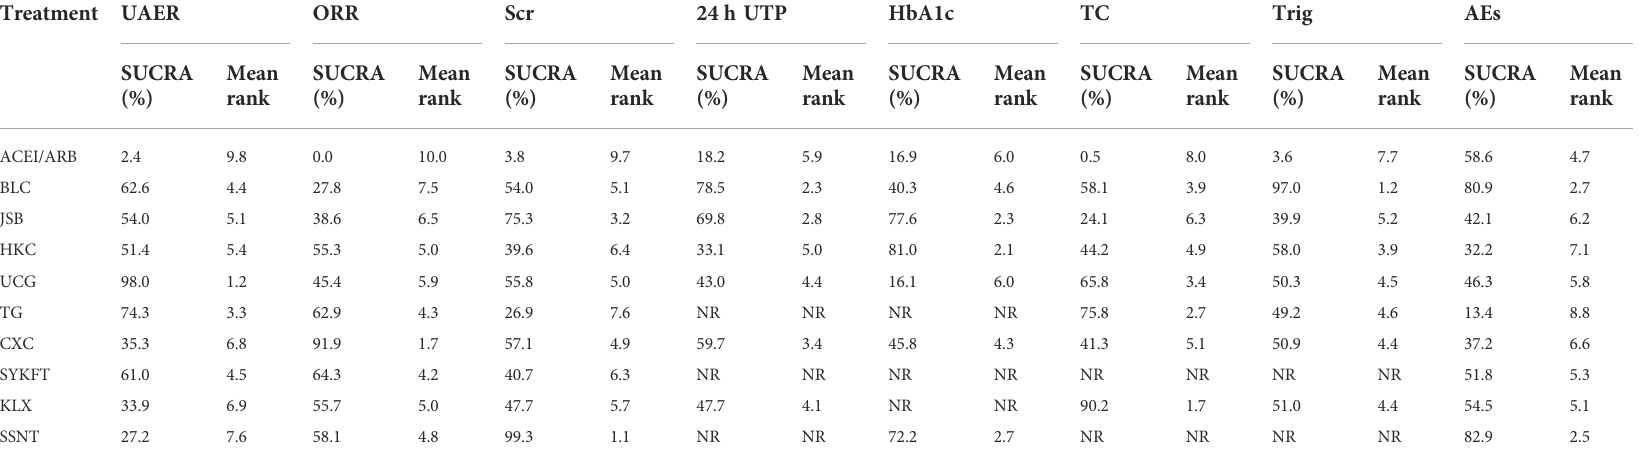
TABLE 1 SUCRA value of primary and secondary outcome indicators. Treatment